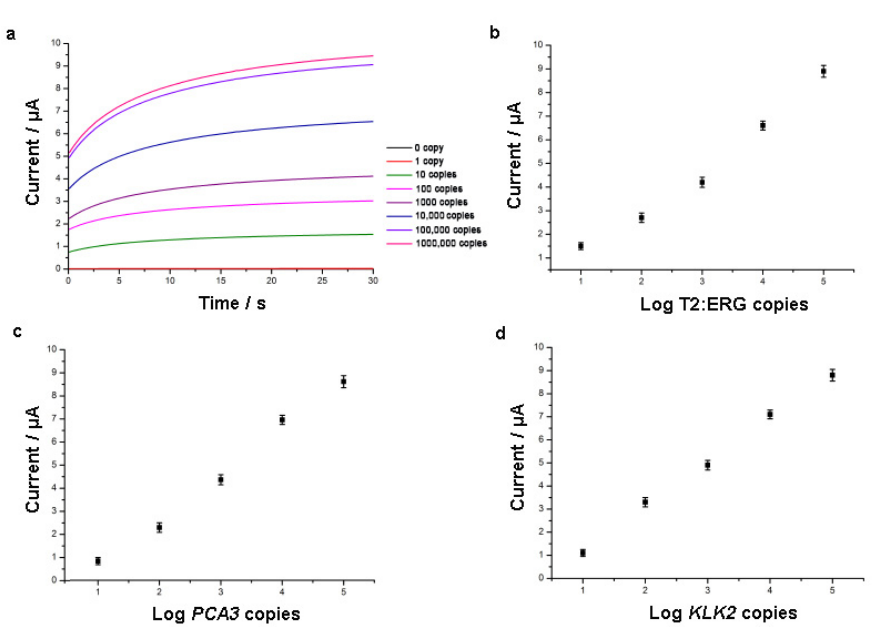
Figure 3. ( a ) Representative chronoamperometric signals for the detection of 0–1,000,000 T2:ERG copies. Detection sensitivity and linear dynamic range for ( b ) T2:ERG, ( c ) PCA3 , ( d ) KLK2 . Error bars represent standard deviations of three technical replicates.